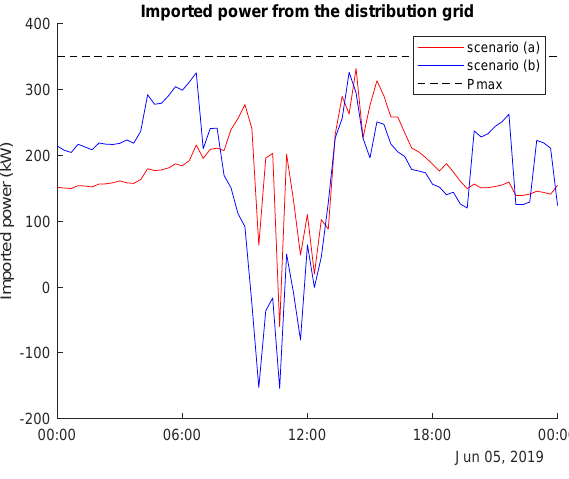
Figure 8. Imported power from grid in both scenarios